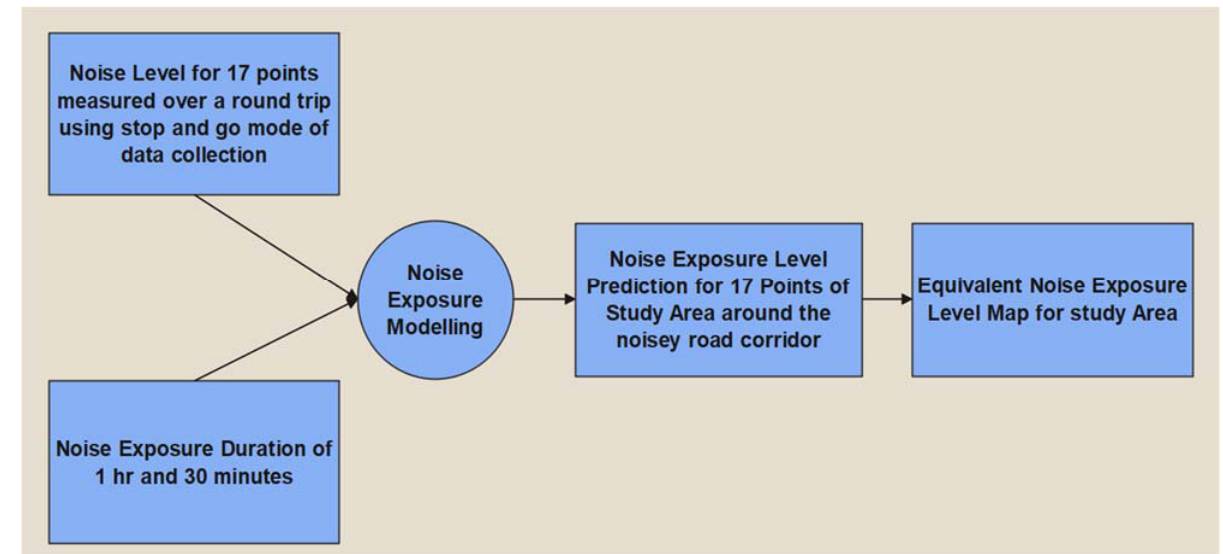
Figure 10. Noise exposure level mapping for the visitors to noisy Bahadurpur intersection .